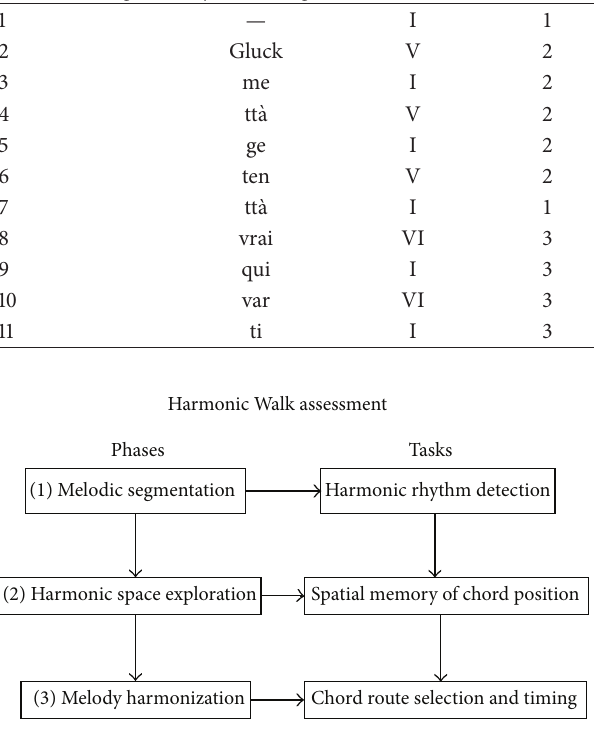
Figure 10: Assessment phases and tasks.